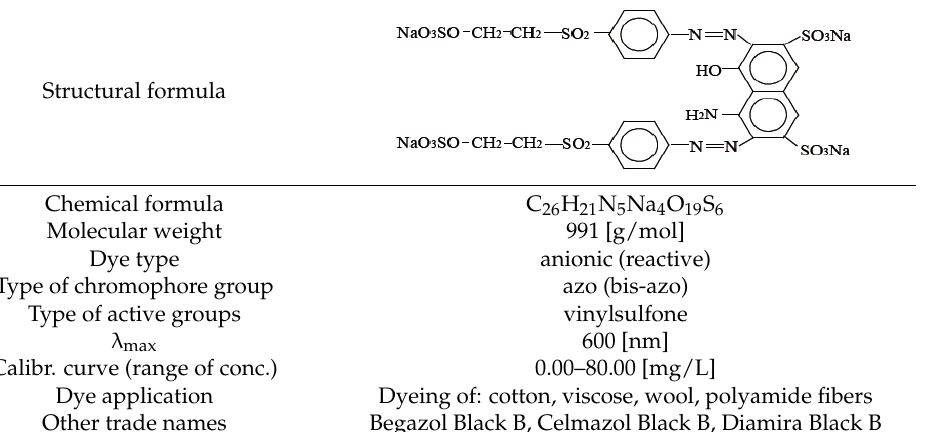
Table 1. Reactive Black 5 dye (RB5) characteristics.